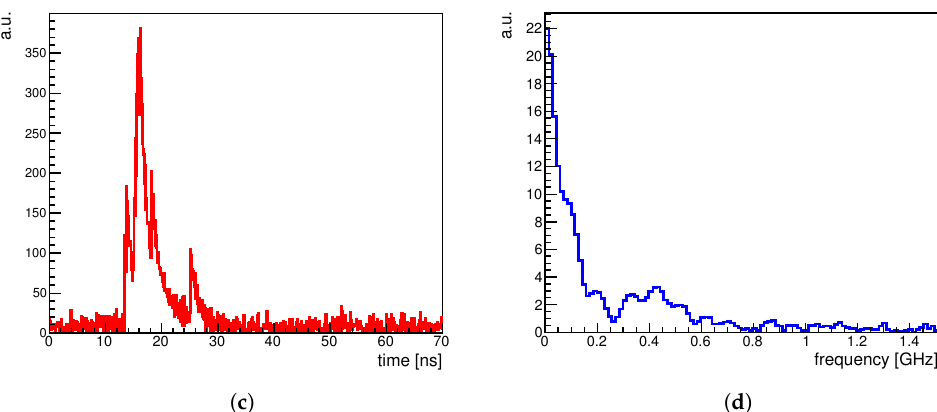
Figure 3. An example of a simulated signal in ( a ) time and ( b ) frequency domains. Signal after decay removal in the ( c ) time and ( d ) frequency domains,